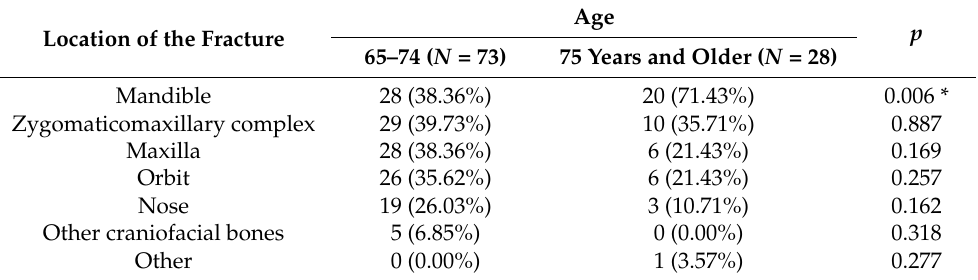
Table 7. Location of the fracture and the patients’ age.